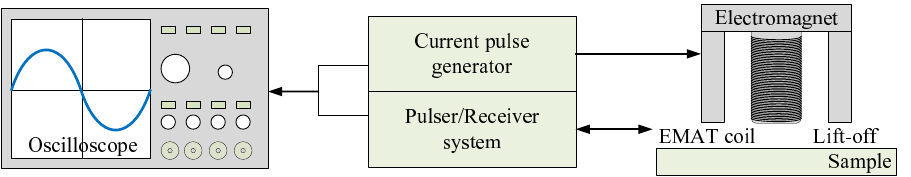
Figure 14. Schematic diagram of experimental electromagnet EMAT